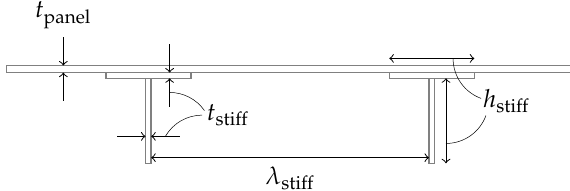
Figure 5. Smeared stiffness panel